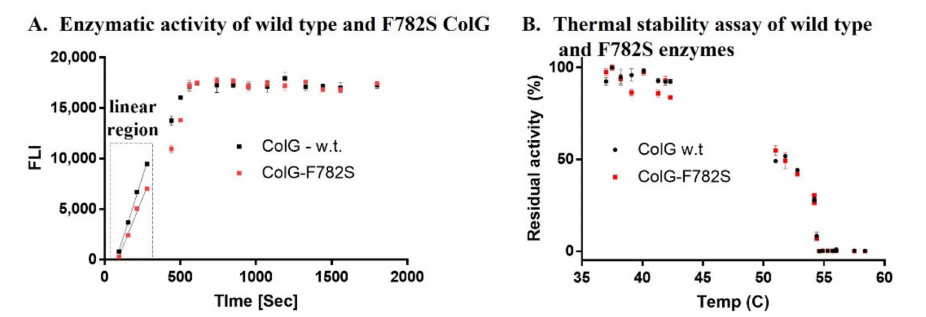
Figure 6. Enzymatic activity and thermal stability of purified enzymes. ( A ) Time-dependent activity of the wild-type and phe782ser variant. The inset shows the linear range of the activity. ( B ) Plot of the residual activity after incubation of the enzymes for 1 h at each